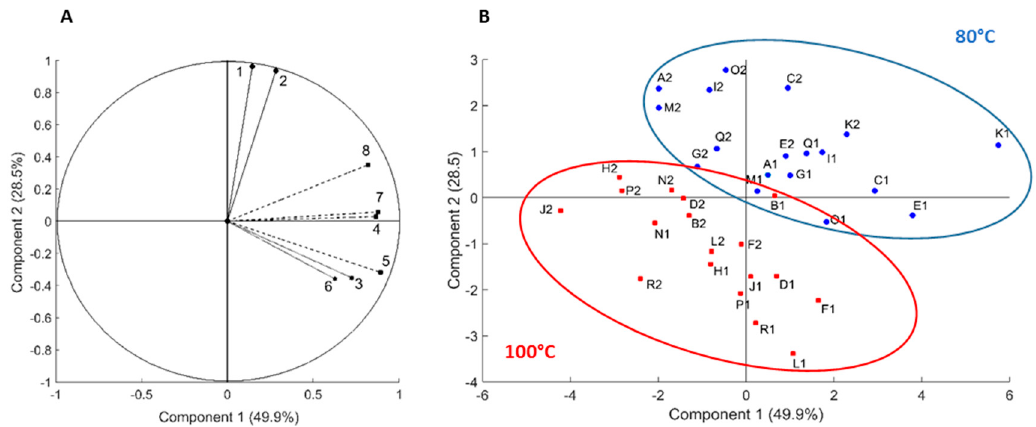
Figure 2. Principal component analysis of the 36 extracts of black spruce bark; ( A ) Correlation circle which displays the 8 targeted molecules correlations on the two principal components (axes); ( B ) Score plot of the 36 extracts (A1 to R2) in function of the two principal components.